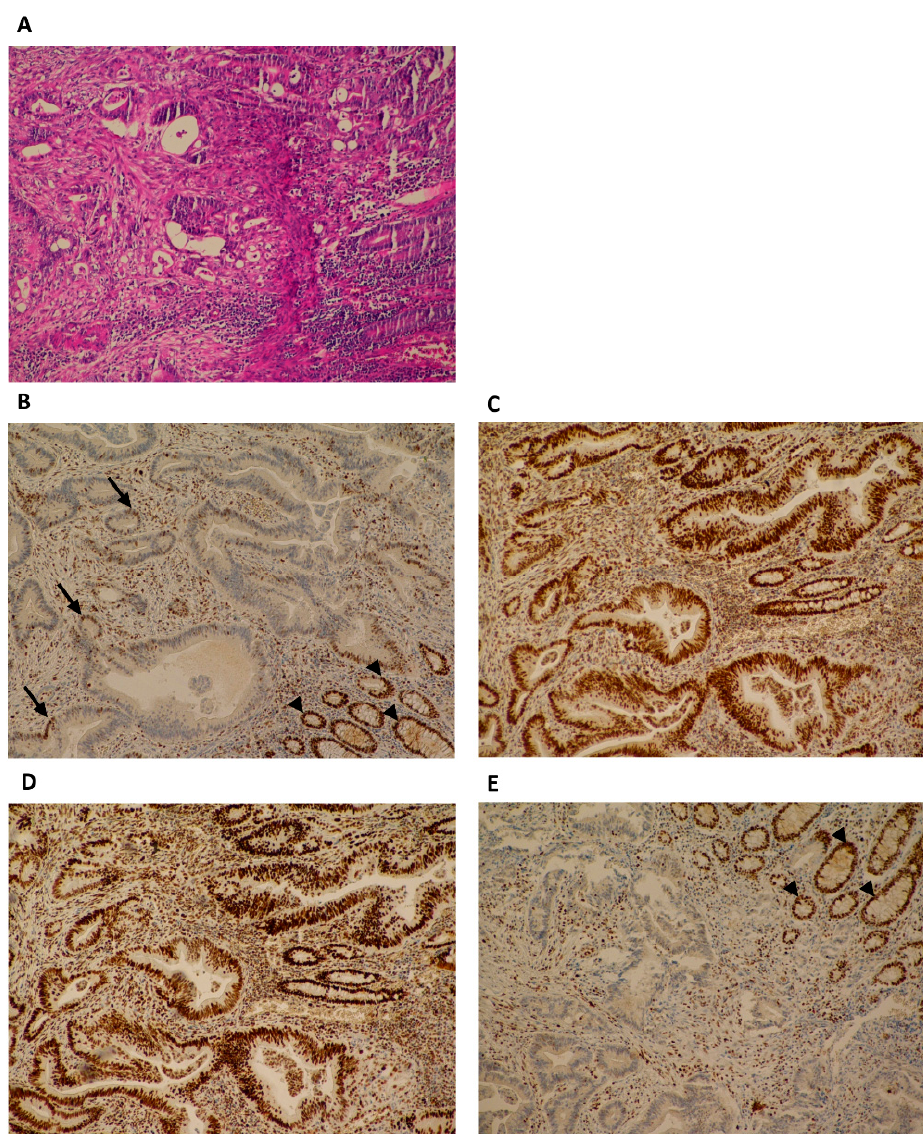
Figure 3. Pathohistological features of proband’s mother’s (II-5) tumor; adenocarcinoma of the ileal flexure. ( A ) Histological analysis (hematoxylin and eosin) revealed a moderately differentiated adenocarcinoma of the ileal flexure. ( B–E ) Immunohistochemical staining of tumor cells showed retained expression of MLH1 (in approximately 5% of tumor cell nuclei; black arrows) ( B ), MSH2 ( C ) and MSH6 ( D ), and loss of expression of PMS2 ( E ). Note that nuclei of normal adjacent epithelium (arrowheads on panel B and E) have an intact expression.